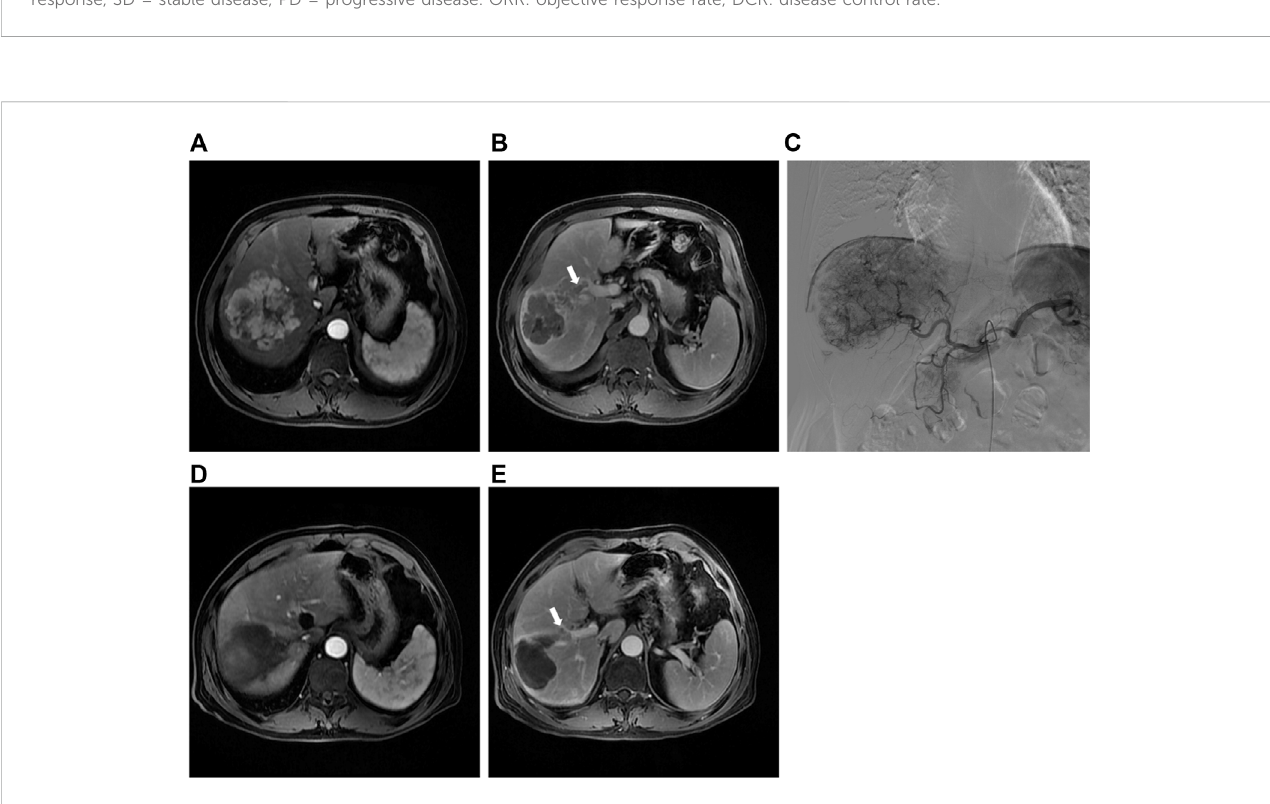
FIGURE 3 (A) Preoperative MRI in the arterial period shows a mass lesion in the right lobe of the liver; (B) Preoperative MRI in the delay period shows tumor thrombus of right anterior portal vein; (C) The intraoperative angiography showed the staining shadow of the mass tumor in the right lobe of the liver. Two drug-eluting beads (300 – 500 μ m, 80 mL irinotecan) and two embolization beads (300 – 500 μ m) were used to embolization the tumor vessels; (D) Abdominal MRI reexamination 3 months after DEB-TACE revealed complete necrosis of the lesion; (E) The tumor thrombus of portal vein was signi fi cantly smaller than